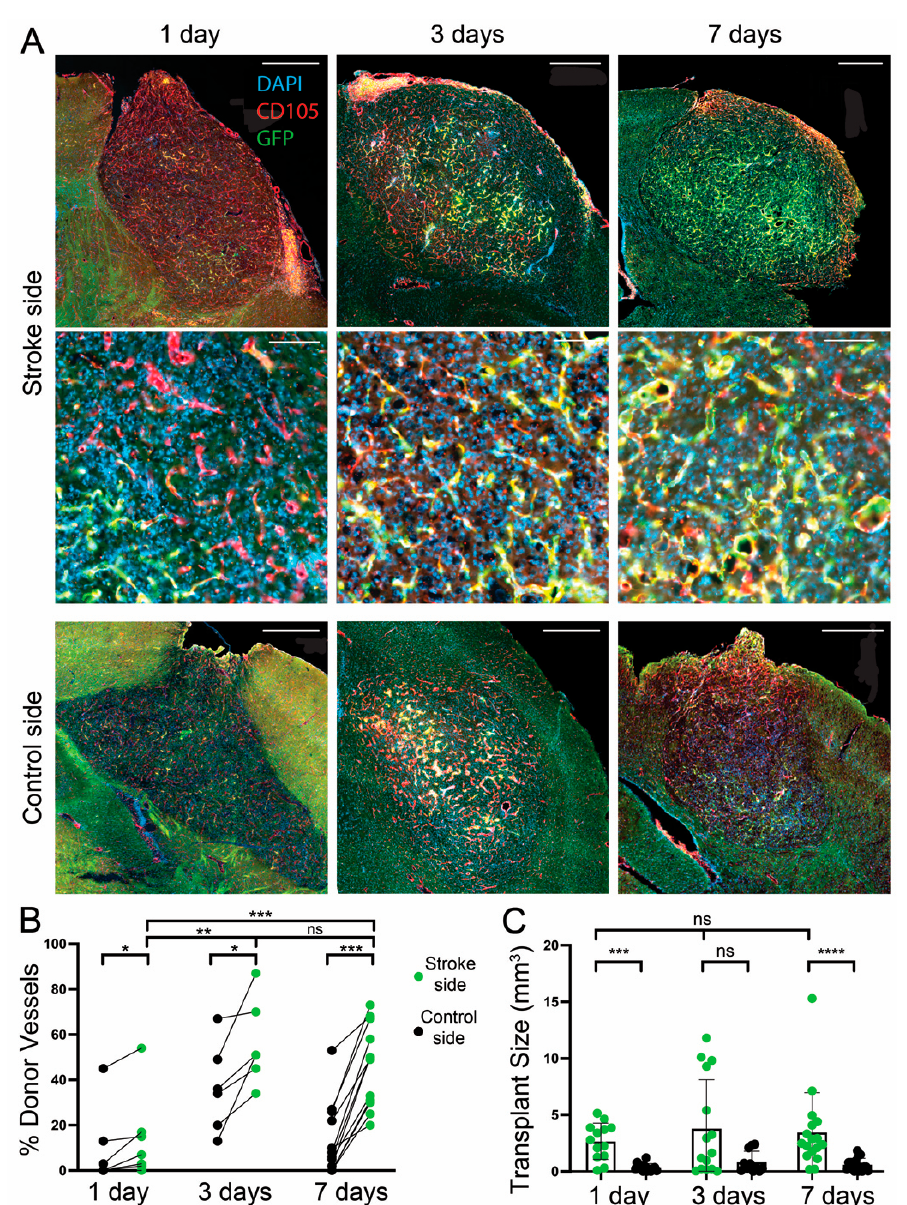
Figure 3. Effect of a transplantation delay of 1, 3, or 7 days after stroke. ( A ) Example images of transplants with a 1-, 3-, and 7-day delay between dMCAO and transplantation (with all brains collected 14 days after transplantation). Top—stroke side; bottom—control side of the same mouse. Scale bars: low magnification, 500 µm; higher magnification, 100 µm. ( B ) Percentage of blood vessels from the donor cell population in grafts. For 1-day delay (n = 7), * p = 0.03; 3-day delay (n = 6); 7-day delay (n = 12), *** p = 0.0005, and 1 vs. 7-day, *** p = 0.0005, 1 vs 3-day, ** p < 0.01. Each pair is one animal; Wilcoxon Test. ( C ) Size of transplants grouped for control and stroke sides. Each dot is a host mouse. For 1-day delay (n = 13), *** p = 0.006; 3-day (n = 15), p = 0.26; 7-day (n = 17), **** p < 0.0001; and 1- vs. 7-day p = 0.4; ns, not significant. Mann–Whitney